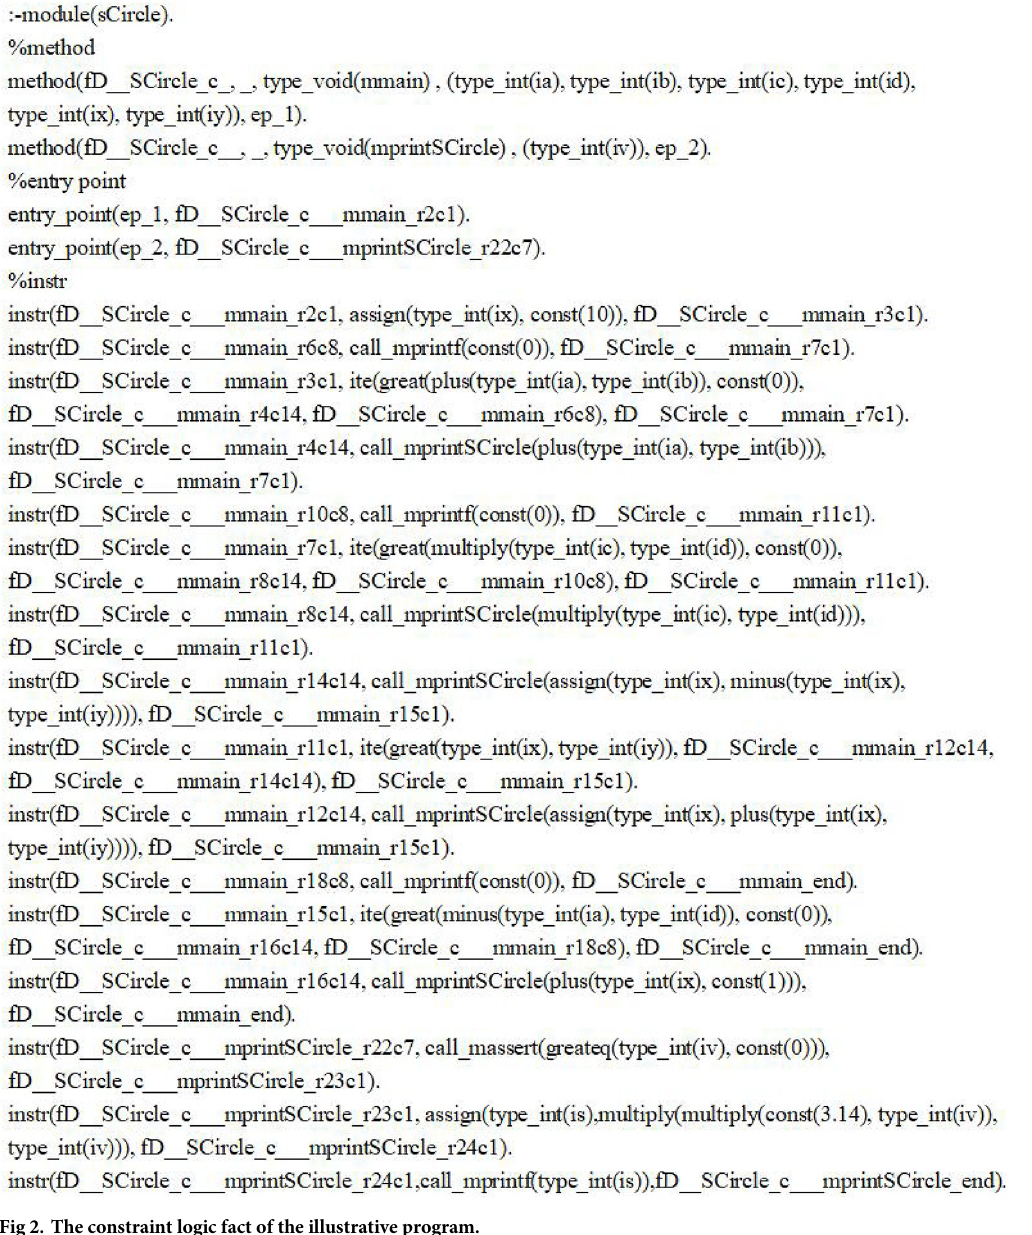
Fig 2. The constraint logic fact of the illustrative